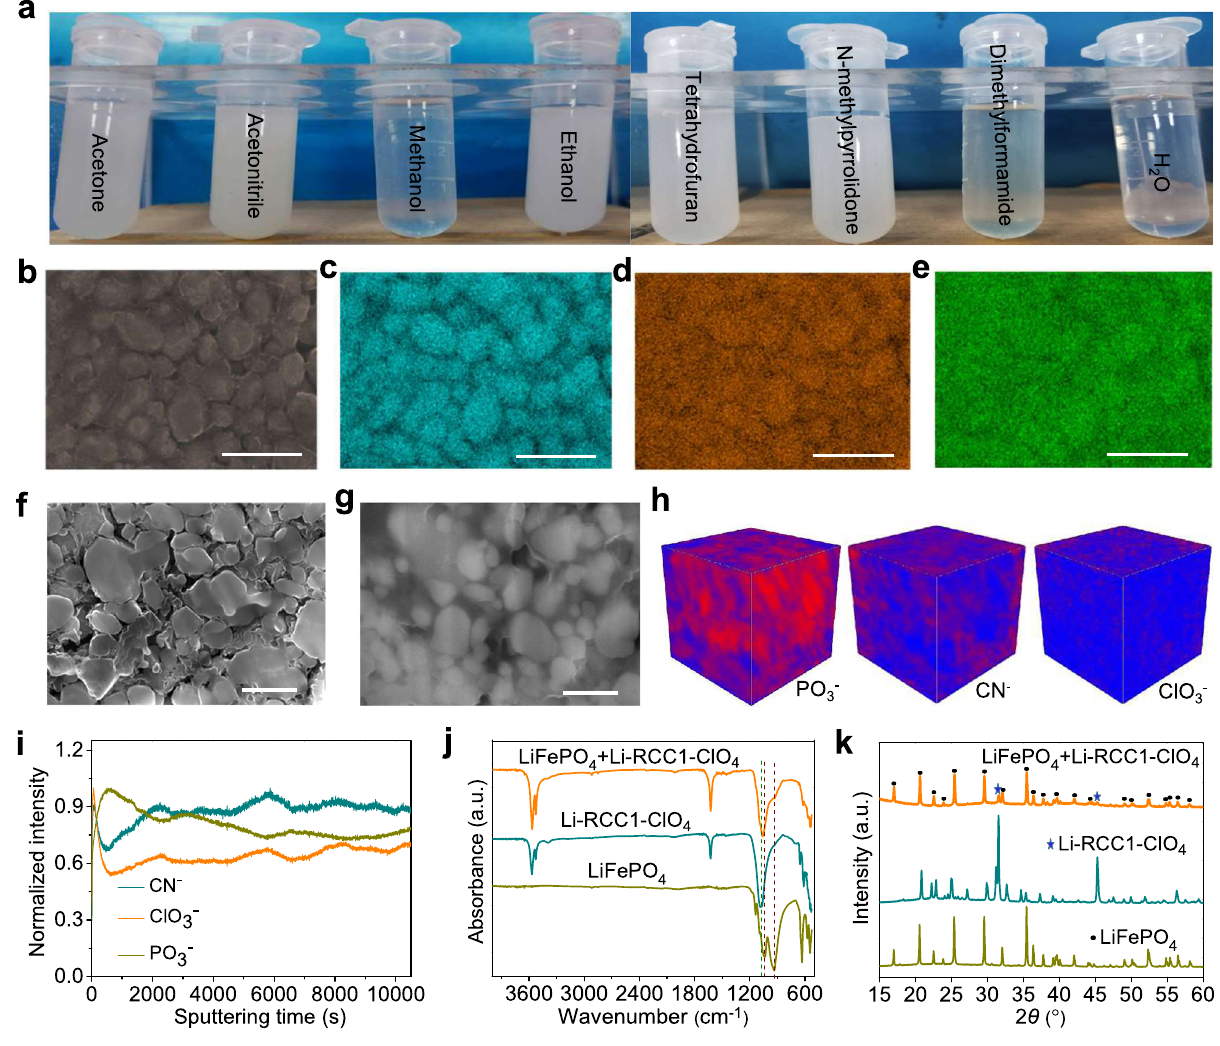
Fig. 3 Characterization of Li-RCC1-ClO 4 in all-solid-state cathodes. a Solubility of Li-RCC1-ClO 4 in different solvents. b SEM image and c – e EDS elemental mappings of Fe, N and Cl in the cathode with Li-RCC1-ClO 4 . SEM micrographs of focus-ion beam cut cross-section of the solid cathodes without ( f ) and with Li-RCC1-ClO 4 ( g ). h TOF-SIMS 3D renderings of the solid cathode with Li-RCC1-ClO 4 . i Normalized TOF-SIMS depth pro fi les of the solid cathode with Li-RCC1-ClO 4 . j FTIR spectra of LiFePO 4 , Li-RCC1-LiClO 4 and mixture of LiFePO 4 and Li-RCC1-ClO 4 . k XRD patterns of LiFePO 4 , Li-RCC1-LiClO 4 and mixture of LiFePO 4 and Li-RCC1-ClO 4 . Scale bars for b – g are all